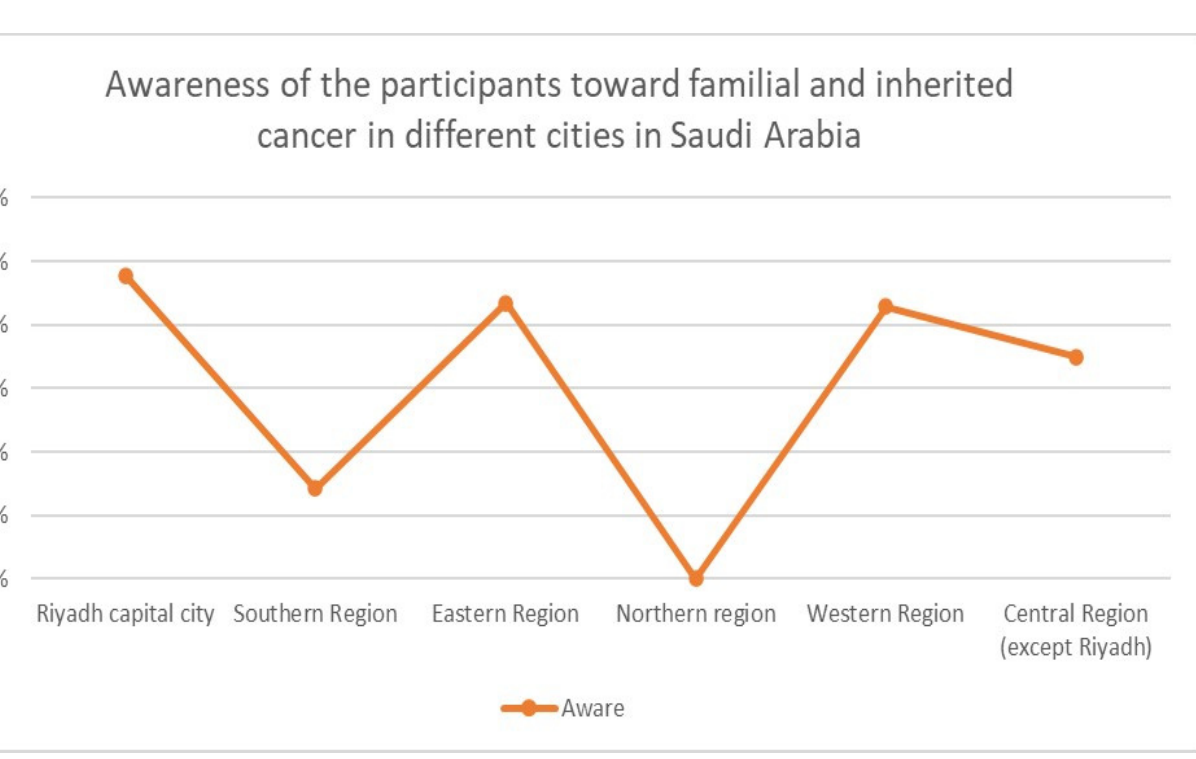
Table 3. Univariate analysis for the assessment of the factors influencing awareness of family and inherited cancer.